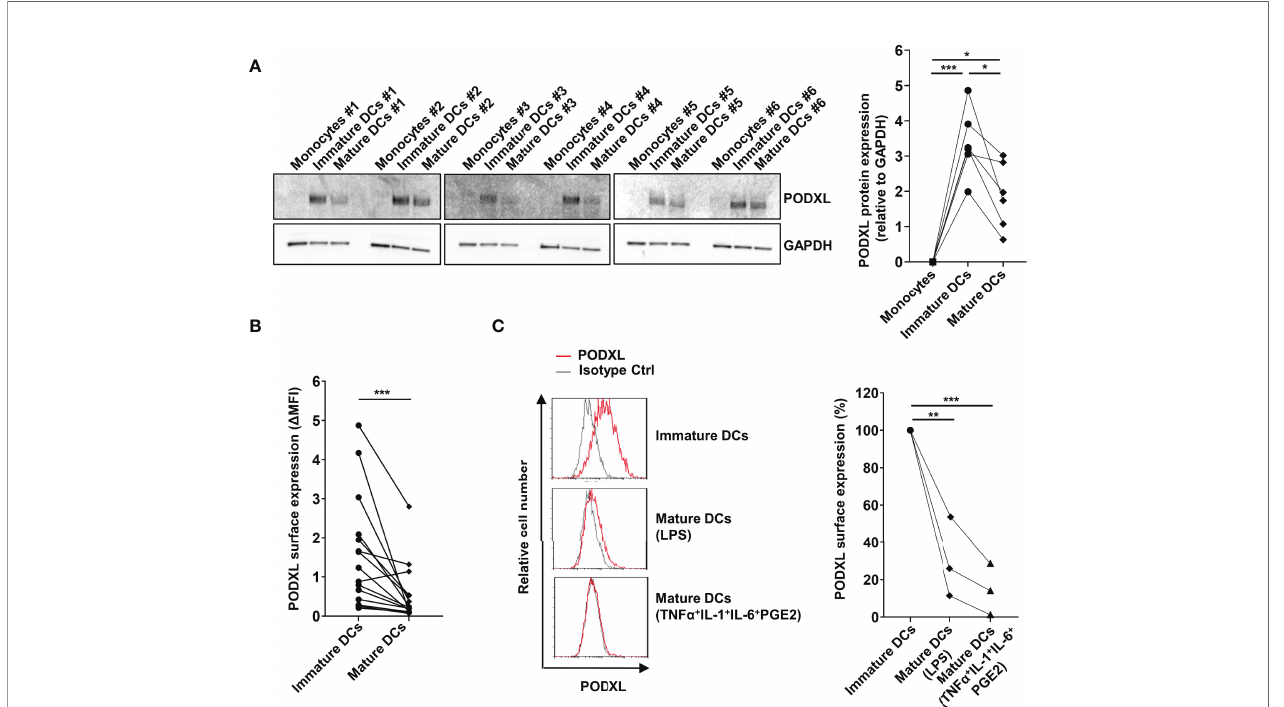
FIGURE 2 | PODXL expression on monocyte-derived DCs is downregulated upon maturation stimuli. (A) Determination of PODXL expression in monocytes, monocyte- derived immature and mature DCs in total cell lysates from six donors by Western blot using a speci fi c mouse anti-human PODXL monoclonal antibody. Monocytes were incubated with IL-4 and GM-CSF for 5 days to obtained immature DCs, followed by incubation with LPS for 2 days to induce DC maturation. GAPDH was used as loading control. The bar graph represents the mean ± SD of PODXL levels relative to GAPDH from the six donors of three independent experiments. *p < 0.05, ***p < 0.001, RM one-way ANOVA. (B) Expression levels of PODXL on the surface of immature and mature DCs from 15 healthy donors using a mouse anti-human PODXL monoclonal antibody followed by PE-conjugated anti-mouse IgG secondary antibody determined by fl ow cytometry. Graph shows PODXL surface expression ( D MFI= PODXL MFI - isotype control MFI). ***p < 0.001, Wilcoxon matched-pairs signed rank test. (C) Mature DCs were obtained by incubating immature DCs with LPS or the maturation cocktail consisting of TNF a , IL-1, IL-6 and PGE2, and PODXL expression levels determined by fl ow cytometry as in (B) . Overlay histograms show surface expression of PODXL (red line) and isotype control (grey line) from one representative donor. The graph represents PODXL expression relative to immature DCs from three donors in three independent experiments. **p < 0.01, ***p < 0.001, one-way